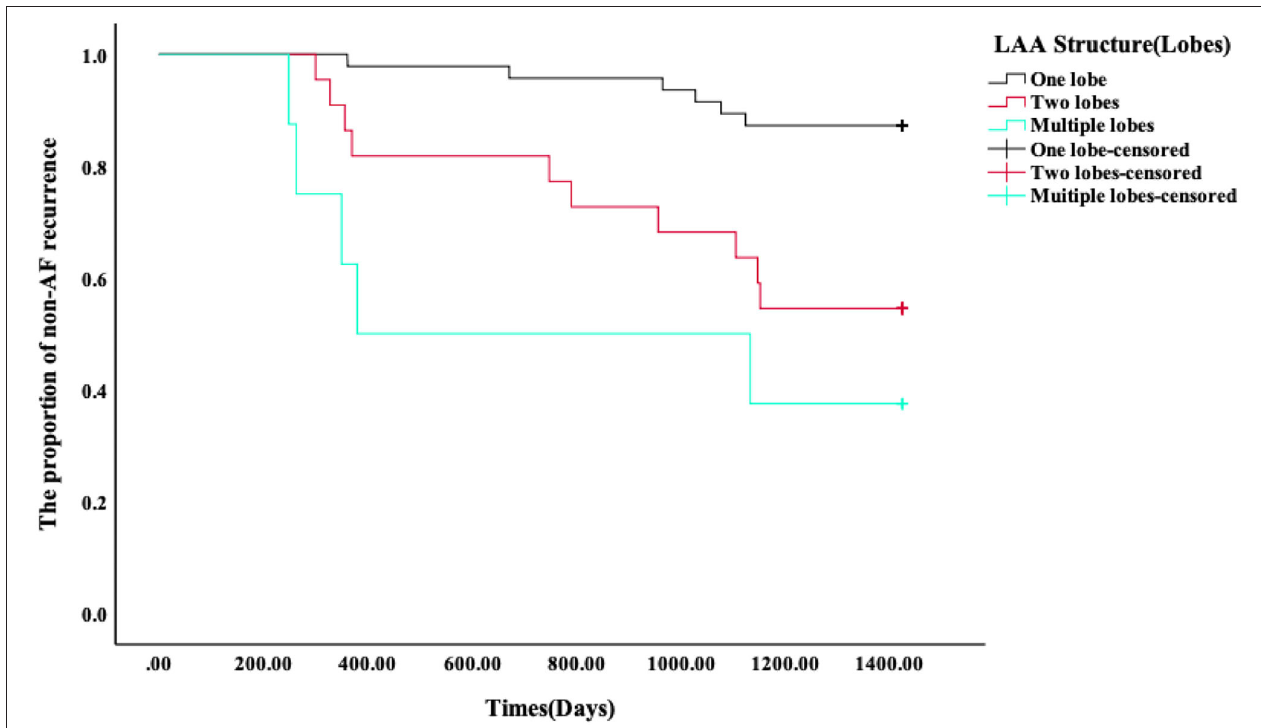
FIGURE 5 | Kaplan–Meier analysis for recurrence after RFA. The Kaplan–Meier survival curves of AF recurrence after ablation and the log-rank test between the three different lobes during 1,460 days of